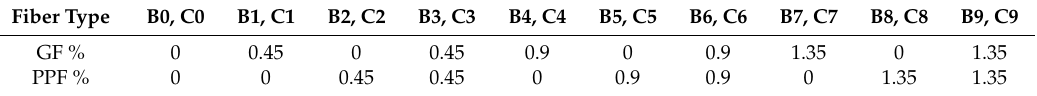
Table 2. Volume percentage of fibres in concrete mixes. PP: polypropylene.